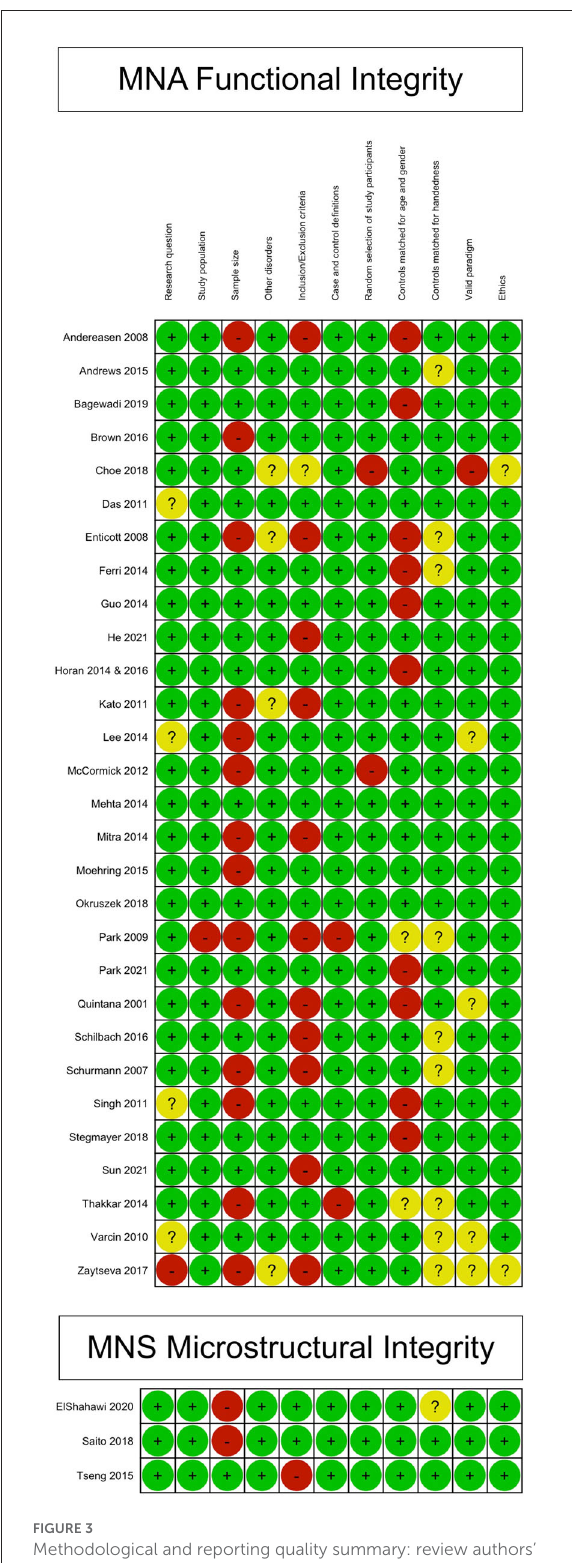
FIGURE3 Methodological and reporting quality summary: review authors’ judgments about each methodological and reporting quality item for each included